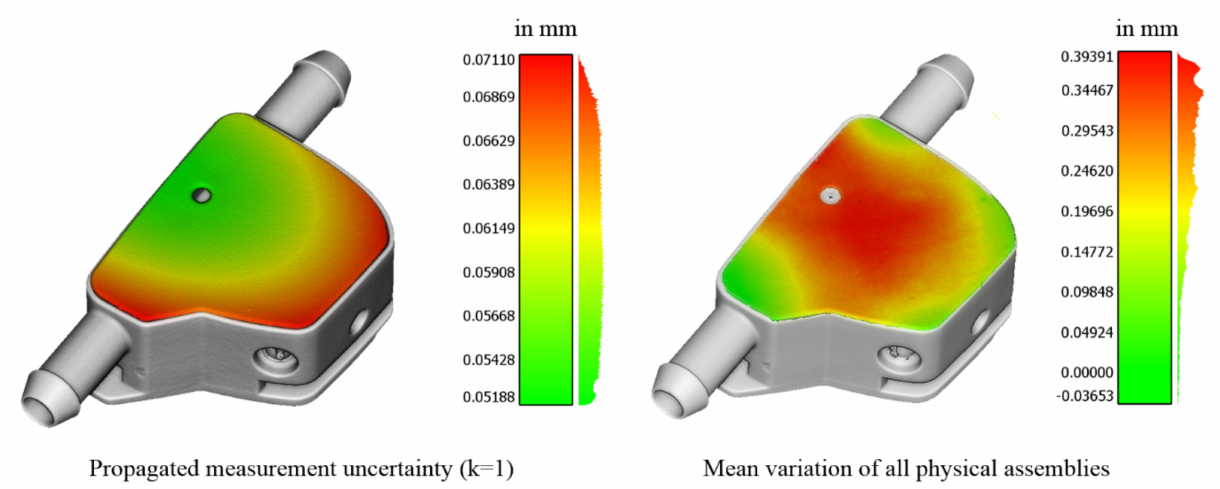
Figure 8. Propagated uncertainty u P at the cover ( left ). Mean variation d PA of all physical assemblies ( right